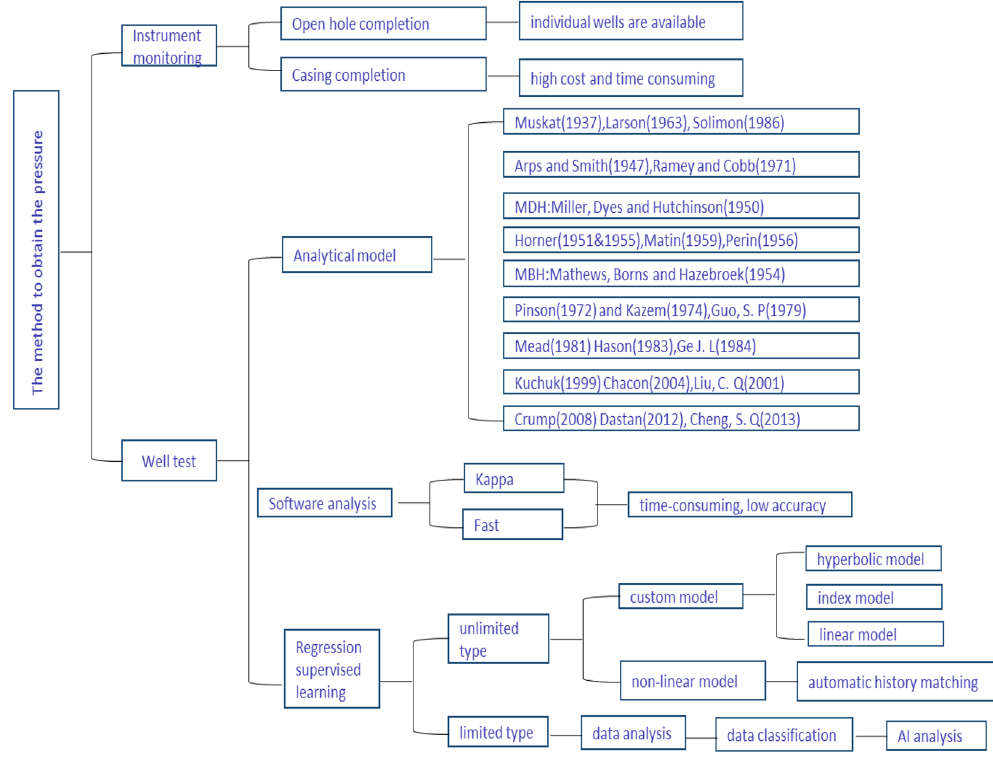
Figure 1. Summary of the methods used in well pressure